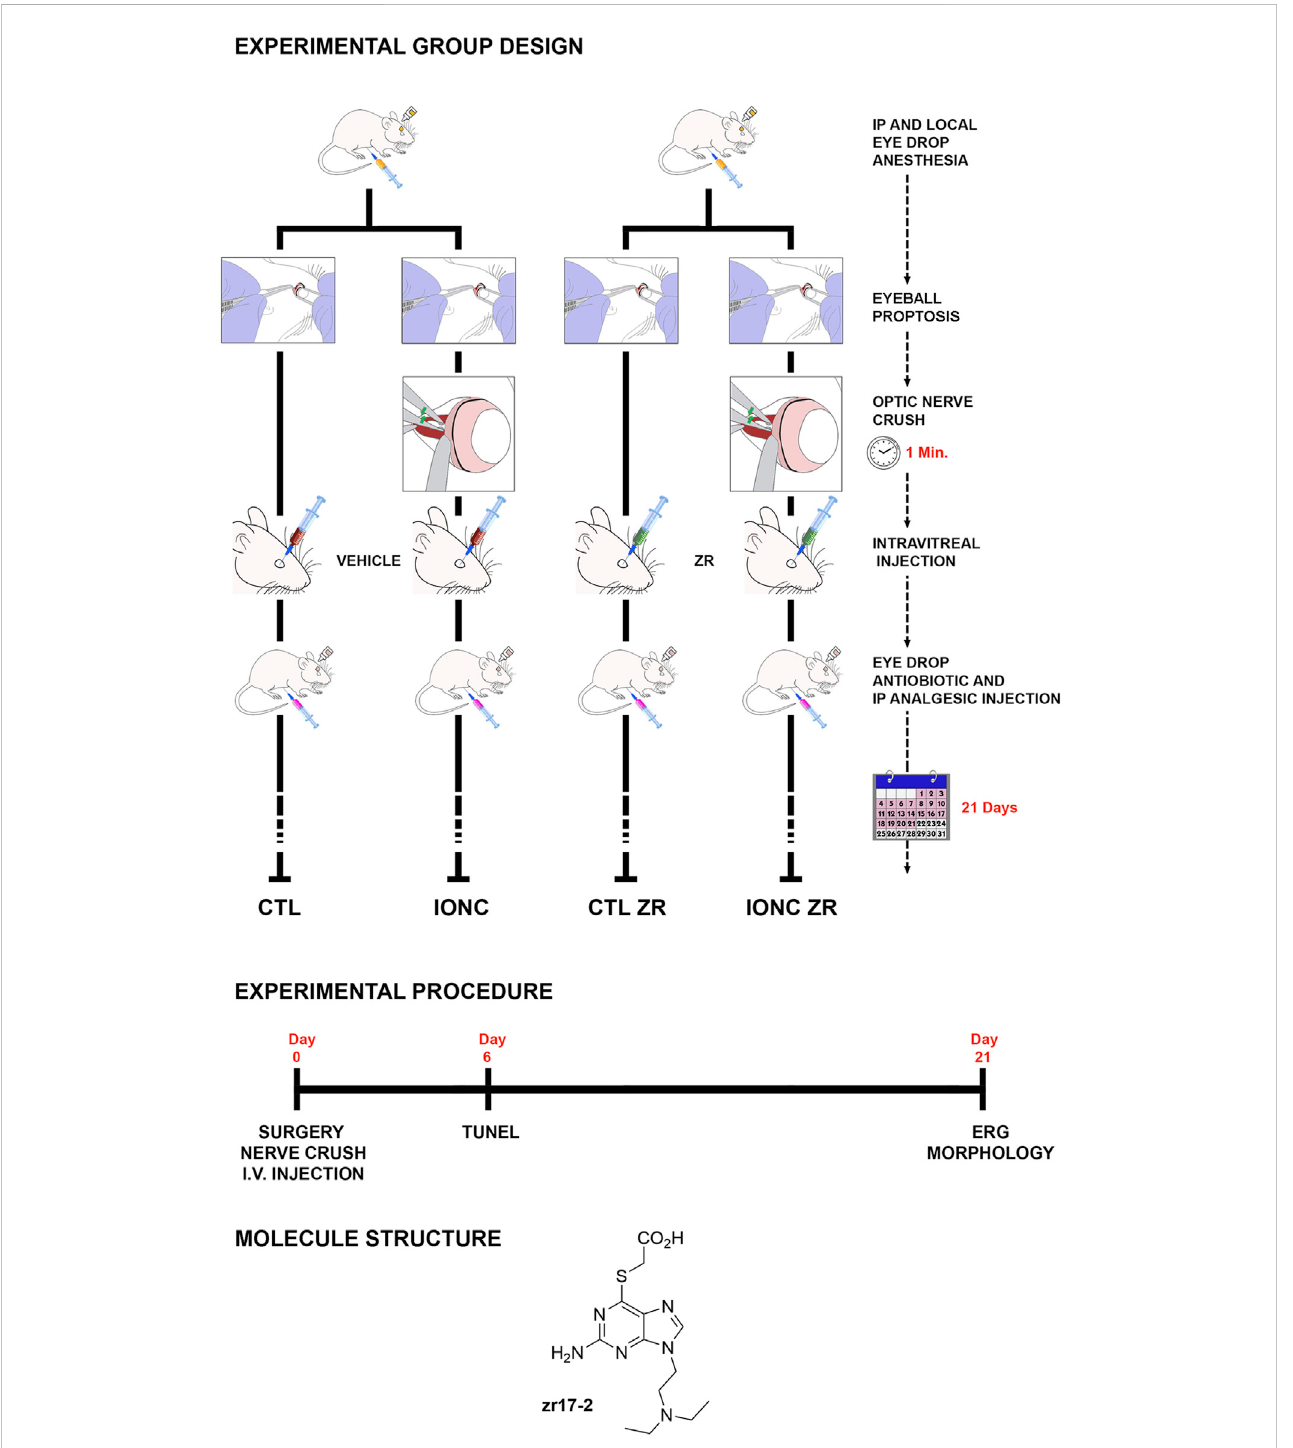
FIGURE 1 Schematic drawing of the different treatments generating the four experimental groups of eyes used in this study: i) Control eyes (CTL) sham operated and injectedwith PBS, ii) Traumatism control (intraorbital optic nerve crush, IONC) and injected with PBS, iii) Control ZR (CTL ZR) sham operated andinjected with zr17-2, iv) Treated traumatism IONC operated and injected with zr17-2 (IONC ZR). The experimental procedure timeline is indicated, as well as the small molecule structure.